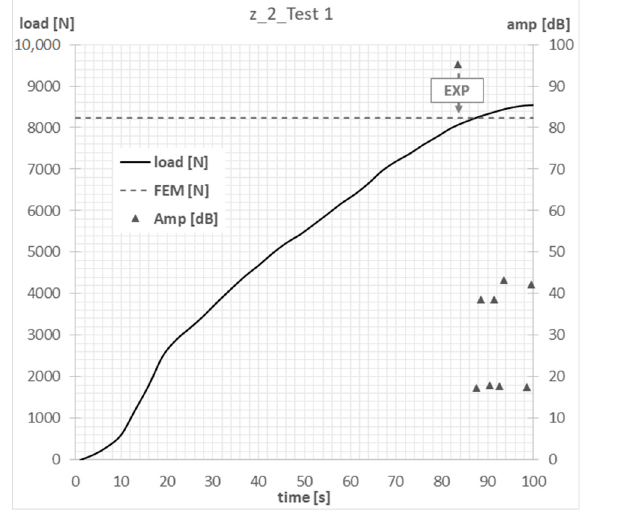
Figure 7. Column z_1—failure initiation force: ( a ) axial compression—Test 1; ( b ) eccentricity—Test